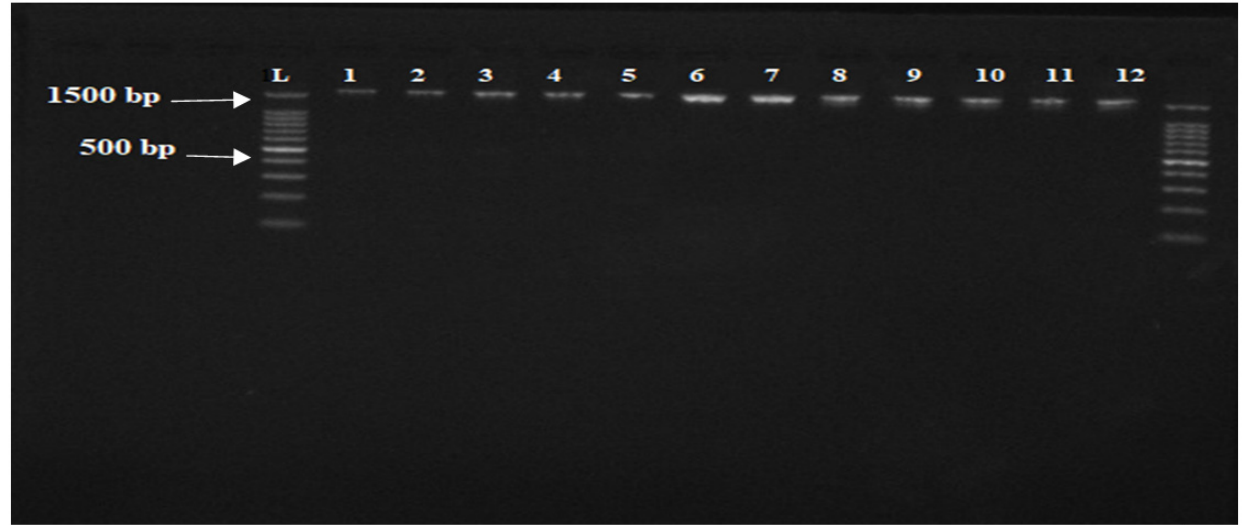
Figure 1. Agarose gel Electrophoresis showing the bands of amplified ERG11 gene. From left to right lanes: L, 100 bp DNA ladder, 1 to 12 lanes are the amplified Candida albicans ERG11 ’s gene (1587 bp).